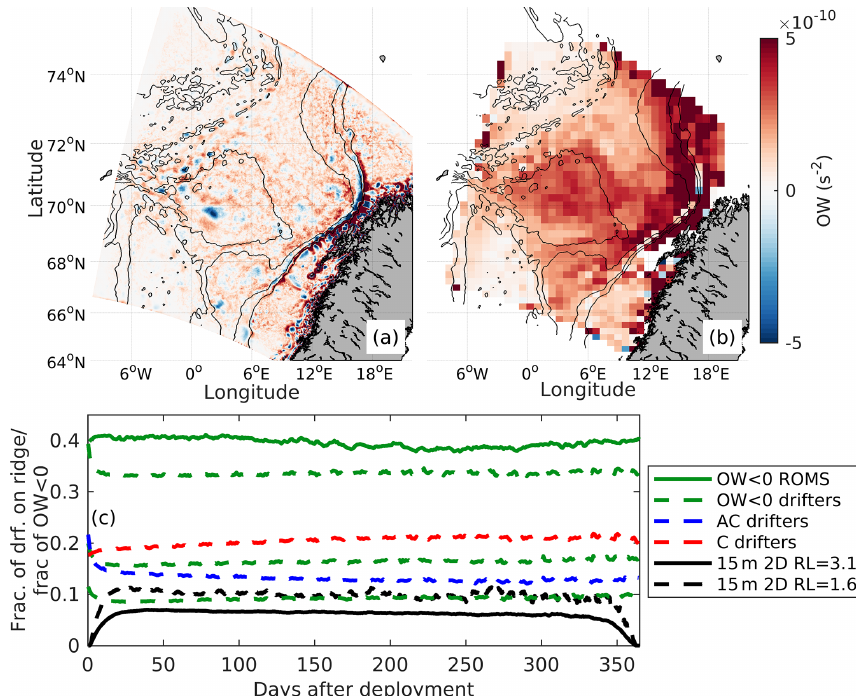
Figure 4. (a, b) The OW parameter (in s − 2 ) (a) from the Eulerian ROMS fields after averaging between 1996 and 2000 (same period as drifters) and (b) from the 2D drifters, bin-averaged after interpolating the ROMS fields to the drifters. (c) Time evolution of the fraction of ridge points normalized by all drifter data points for 2D drifters deployed at 15m after running the MWRA routine with a minimum allowed ridge length of 3.2 cycles (solid black) and 1.6 cycles (dashed black). This is compared to the fraction of grid points with OW < 0 from the Eulerian ROMS fields (solid green) at 15m depth during a random year (1999) within the drifter simulation period. Dashed green lines show the fraction of data points along drifter trajectories with OW < 0 normalized by the total number of drifter data points for every time step with the constraint that OW < 0 for at least 0d (upper), 1d (middle) and 2d (lower). Red and blue curves are for OW < 0 with positive (red) or negative (blue) relative vorticity.